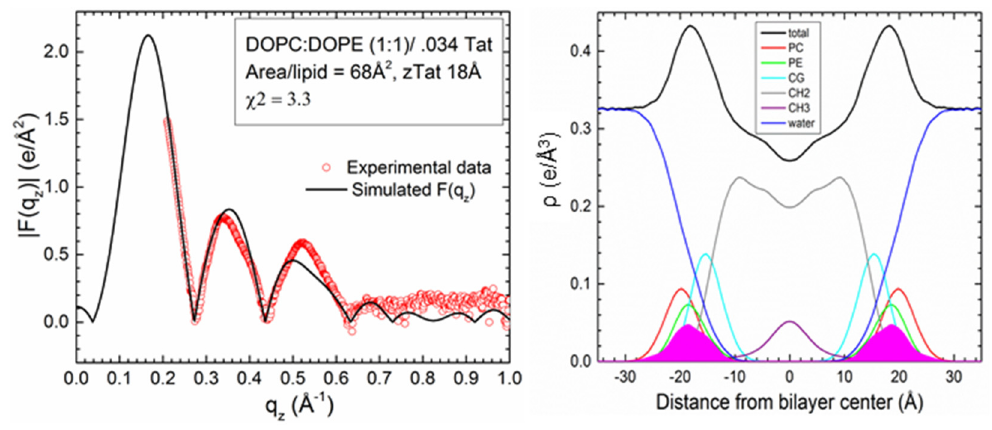
Figure 6. Detailed comparison of |F(q z )| ( left ) between DOPC:DOPE (1:1) with a Tat 47–57 mole fraction of 0.030/0.034 (simulation/experiment) at the value of z and A L that yielded the smallest χ 2 value: z = 18 Å, A L = 68 Å 2 , χ 2 = 3.26 ± 0.16. Experimental data were scaled to the simulated |F(q z )|. Electron density profile ( right ) of the same simulation with component groups indicated in the figure legend. Tat 47–57 electron density shown in solid magenta; other abbreviations as in Figure